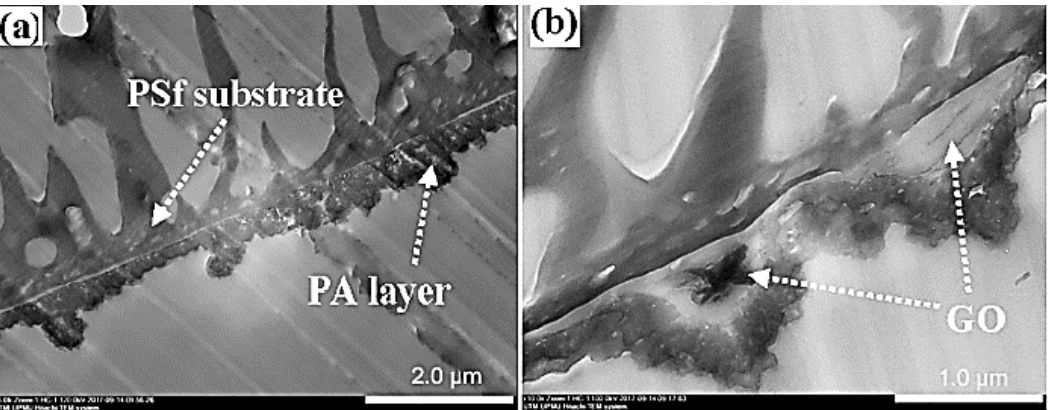
Figure 14. TEM cross-sectional images of ( a ) polysulfone/polyamide and ( b ) polymer with 0.02 wt.% GO membranes [145]. Reproduced from reference [145]. Copyright 2018 Elsevier.